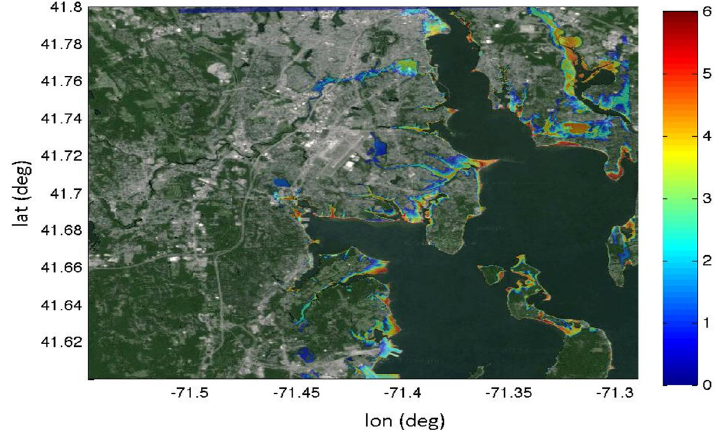
Figure 14. Controlling wave height (m) for Warwick, RI, 100 year event.